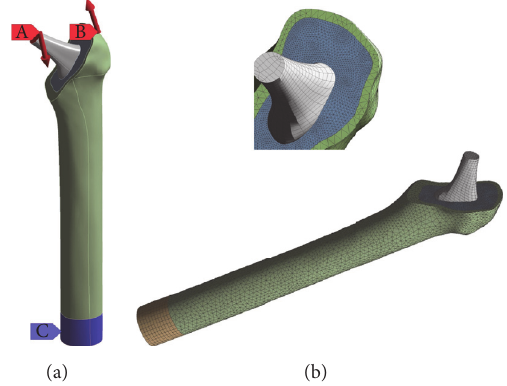
Figure 5: (a): (A) body force, (B) abductor muscle force, and (C) fixed support. (b): unstructured mesh with a combination of Tetrahedron, Patch Conforming, and Sweep Method was used for the